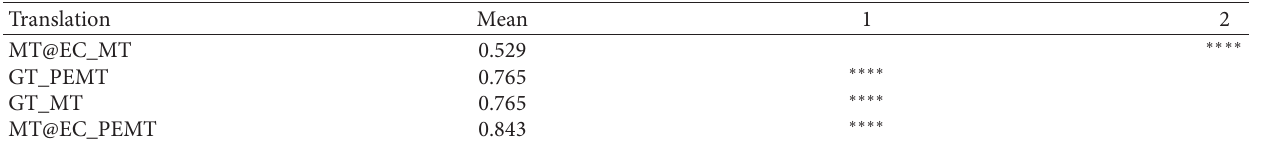
Table 4: Homogeneous groups for incidence of frequent tagsets in examined translations.